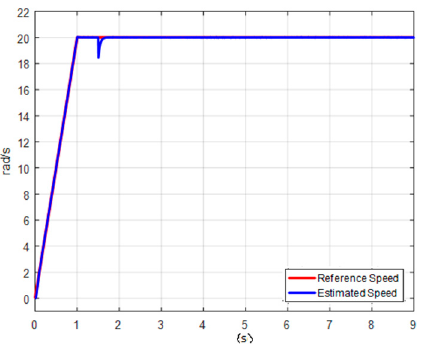
Figure 7. Rotor ( a ) and stator ( b ) resistances of induction motor: real resistances and estimated resistances.